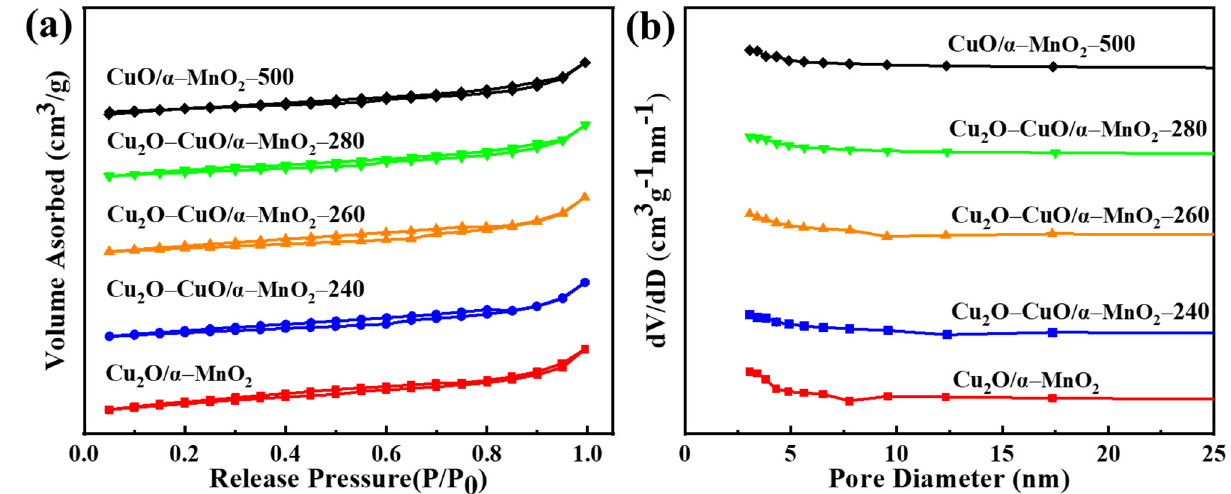
Figure 7. ( a ) N 2 adsorption–desorption isotherms and ( b ) pore size distribution curves of the